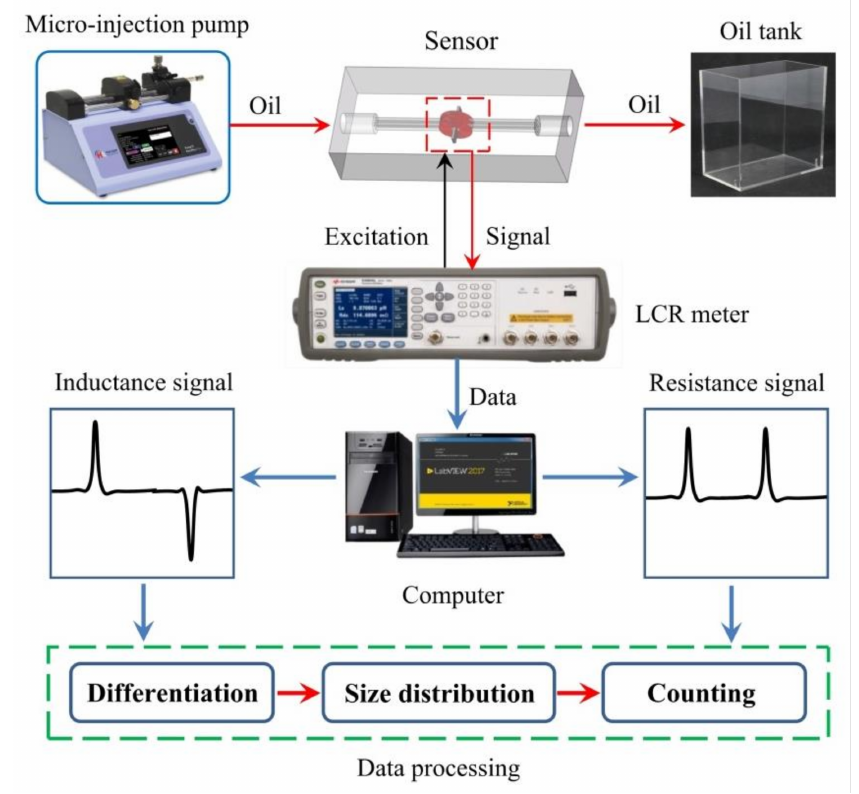
Figure 4. Impedance detection